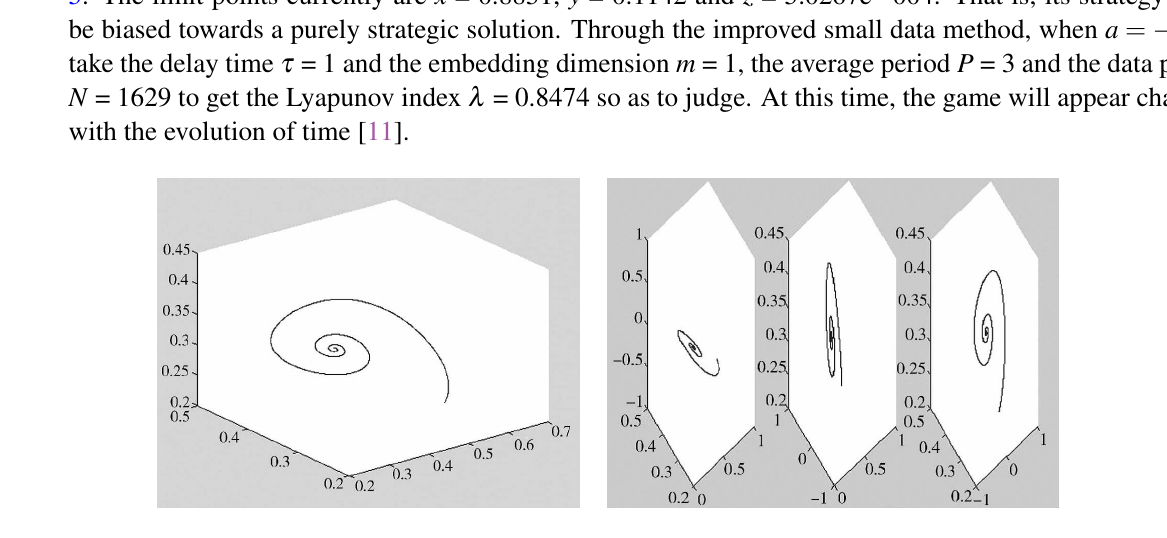
Fig. 5 Orbital solution when parameter a = 1